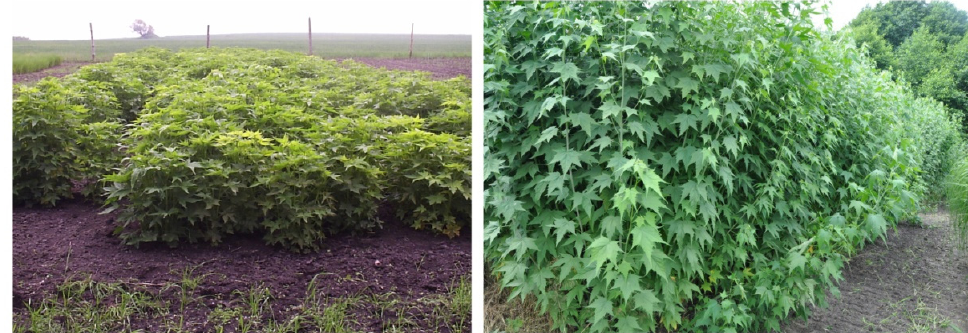
Figure 1. Sida in various stages of development.